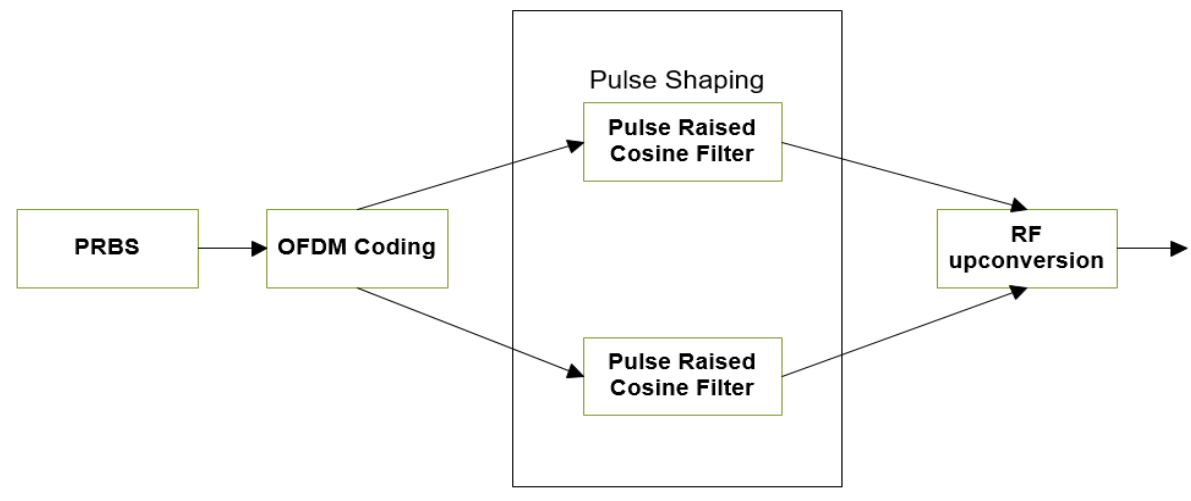
Figure 3. Block diagram of the implementation of the Orthogonal Frequency Division Multiplexing (OFDM) transmitter. PRBS: Pseudorandom Binary Sequence; RF: Radio (OFDM) transmitter. PRBS: Pseudorandom Binary Sequence; RF: Radio Frequency.